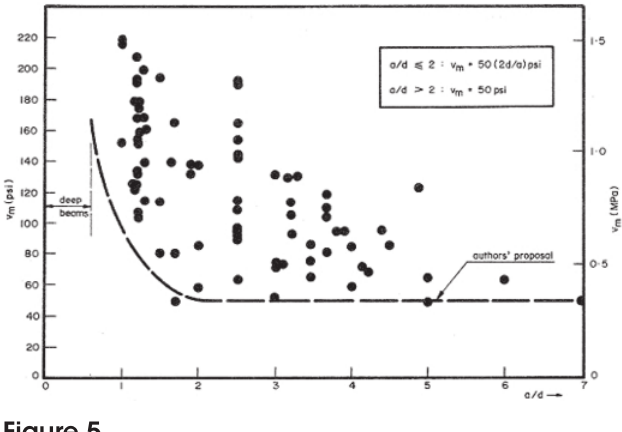
Vm x a/d Source: Suter and Keller